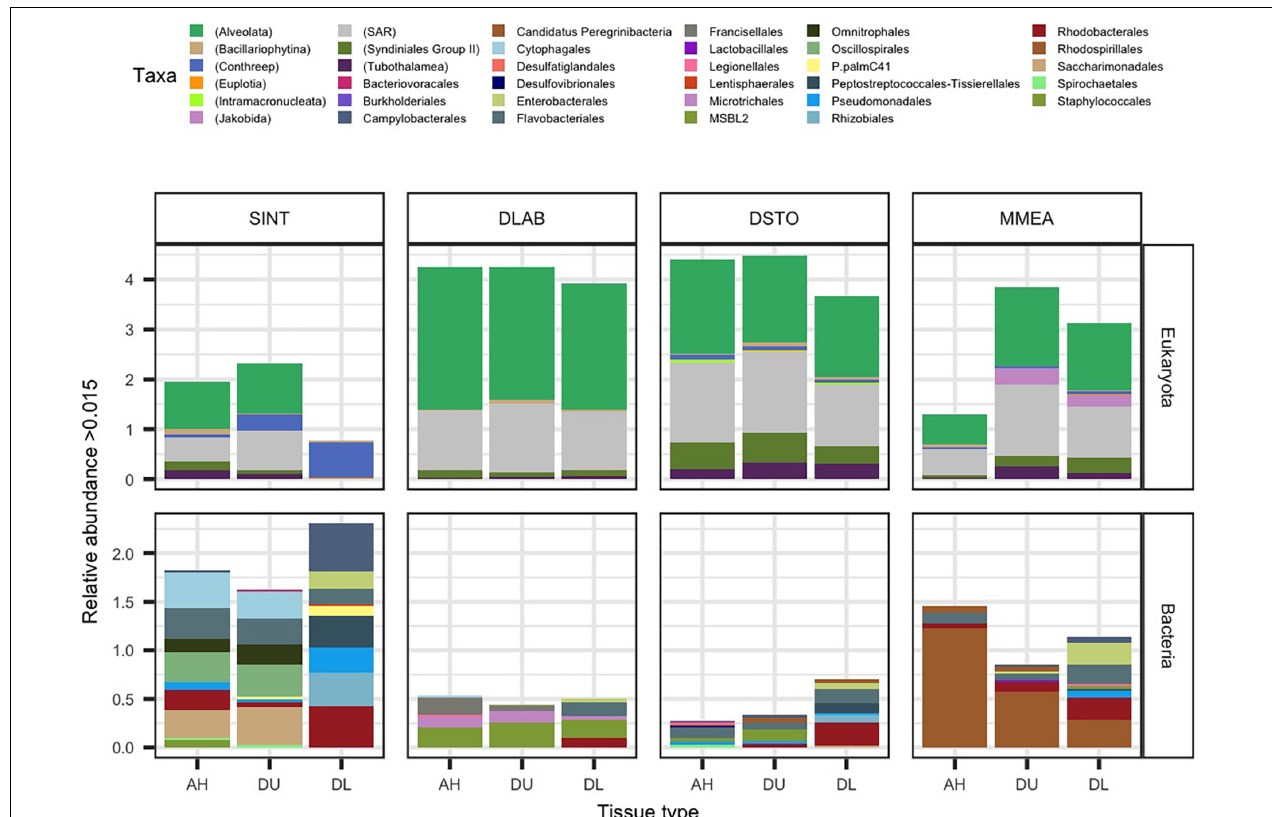
FIGURE 1 | The average relative abundance of significantly differentially abundant rRNA gene counts (padj ≤ 0.05 from ANCOMBC). Samples from apparently healthy colonies (AH), and unaffected (DU) and lesion (DL) tissues on diseased colonies, of the coral species Stephanocoenia intersepta (SINT), Diploria labyrinthiformis (DLAB), Dichocoenia stokesii (DSTO), and Meandrina meandrites (MMEA) were evaluated for micro-eukaryotic (18S rRNA; top panel ) and bacterial (16S rRNA; bottom panel ) for differential abundance. The most abundant significant taxa are plotted by relative abundance. The stacked bar is colored either by the lowest taxonomic designation for eukaryotes (denoted by parenthesis in the key) or order for